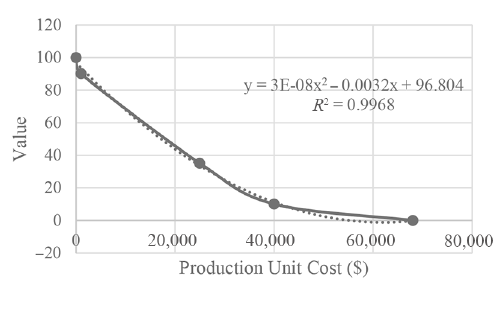
Figure 7. CEP value function